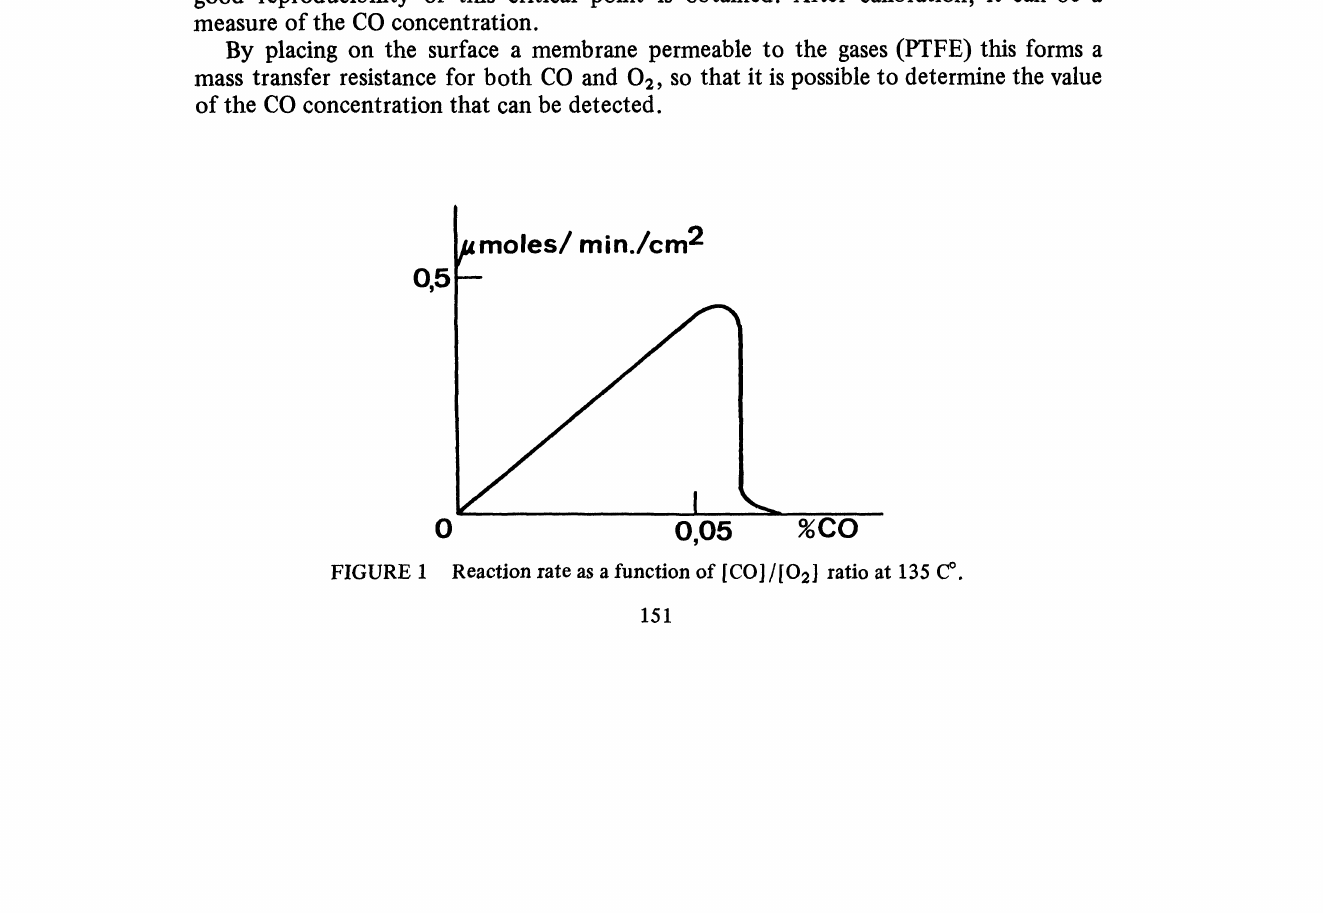
Reaction rate as a function of [CO]/[O2] ratio at 135 C